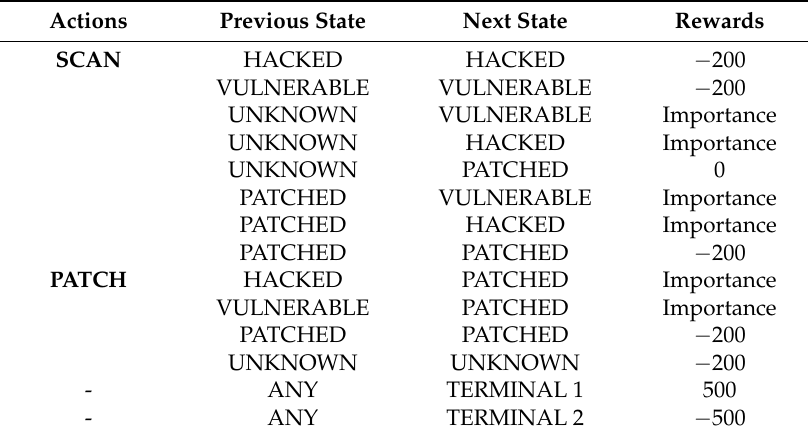
Table 6. State transition and